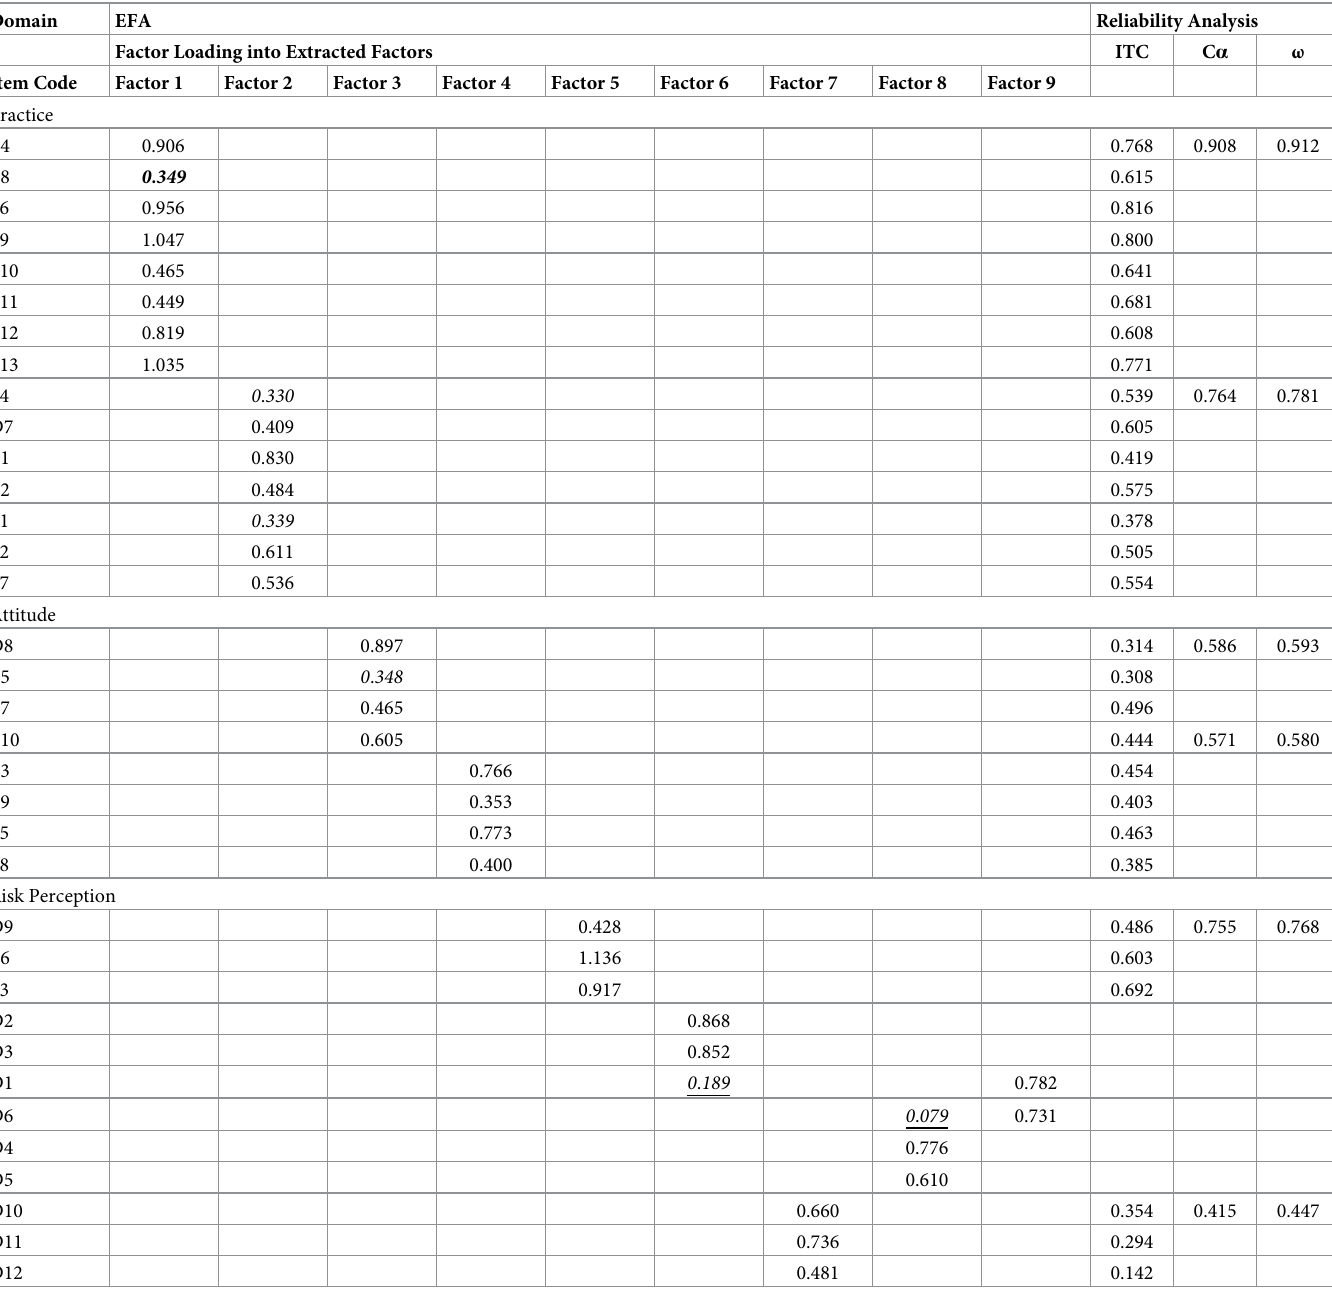
Table 3. Results of EFA and reliability analysis of all 35 items with respective factor loadings, ITC, and domain-specific Cronbach α , as well as McDonald’s omega.